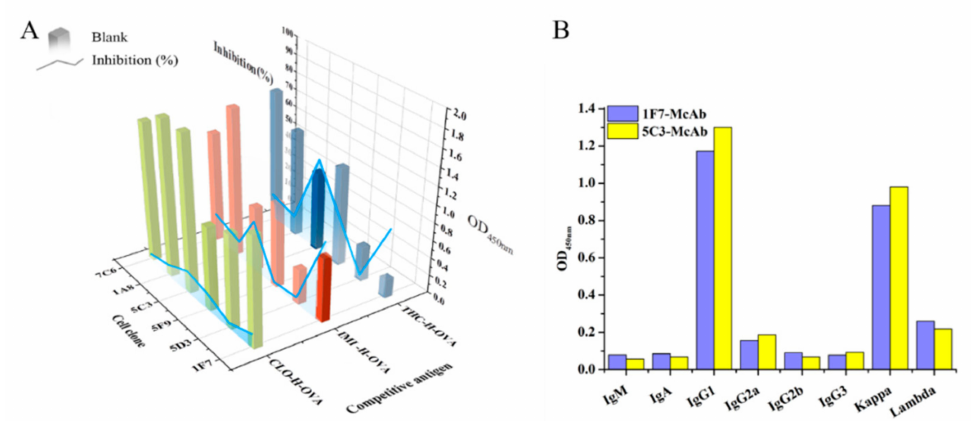
Figure 1. Characterization of antibodies from hybridoma supernatants. Screening hybridoma using ic - ELISAs with different competitive antigens. The concentration of competitive antigen was 5 µ g/mL. The inhibition was tested with 50 µ g/L of clothianidin ( A ). The isotypes determination of two antibodies ( B